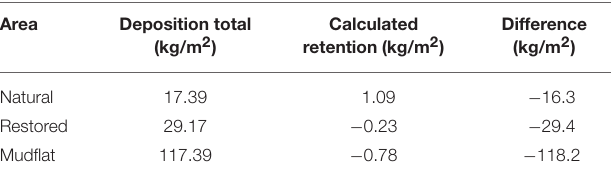
a discontinuity between rates of deposition and accretion.